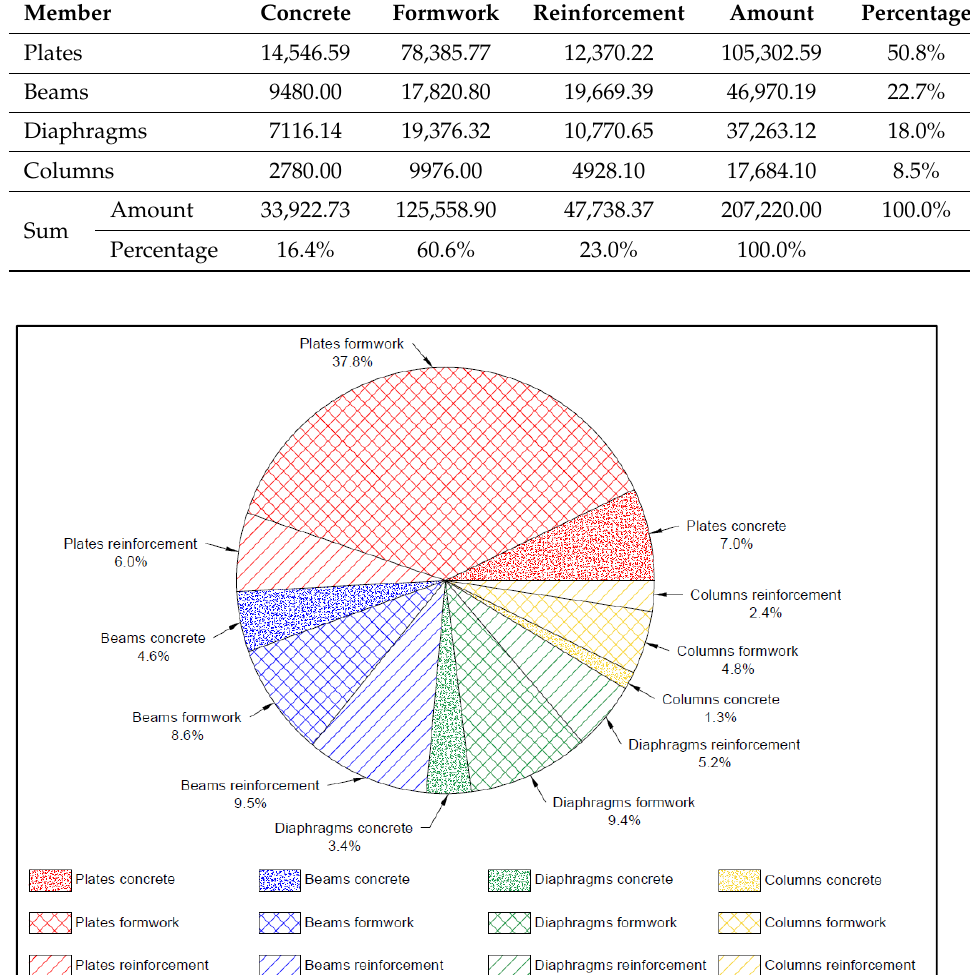
Table 30. Distribution of the optimum cost values among different materials and structural parts for the three-segment type folded plate roof building.